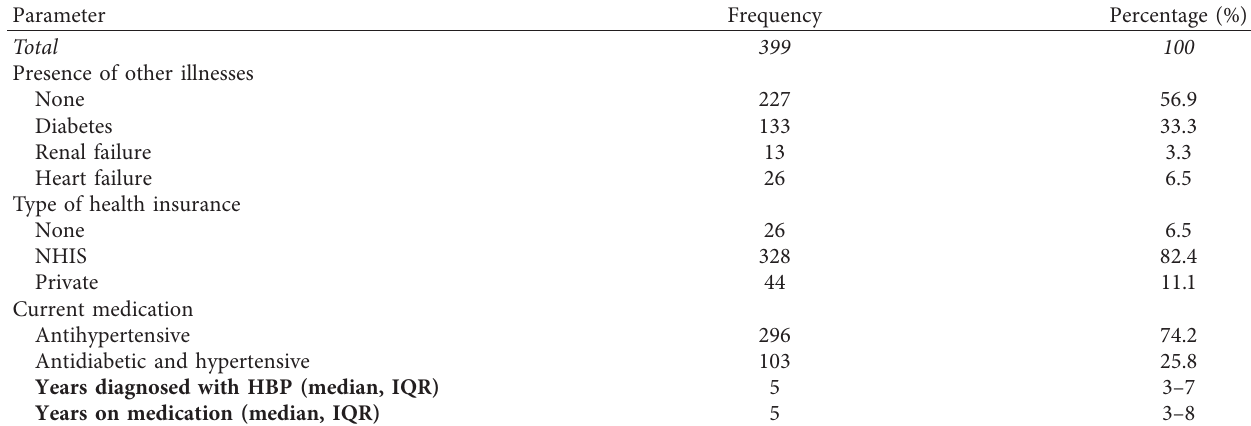
Table 3: Clinical characteristics of study participants.